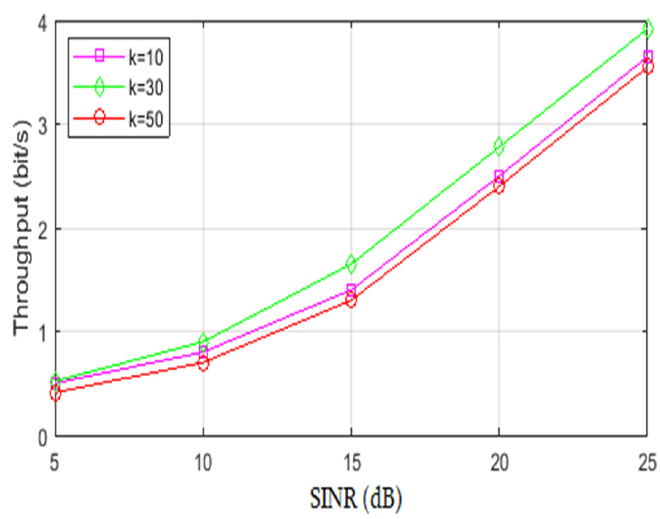
Figure 5. Throughput versus SINR for the various k values in RLA–KNN.